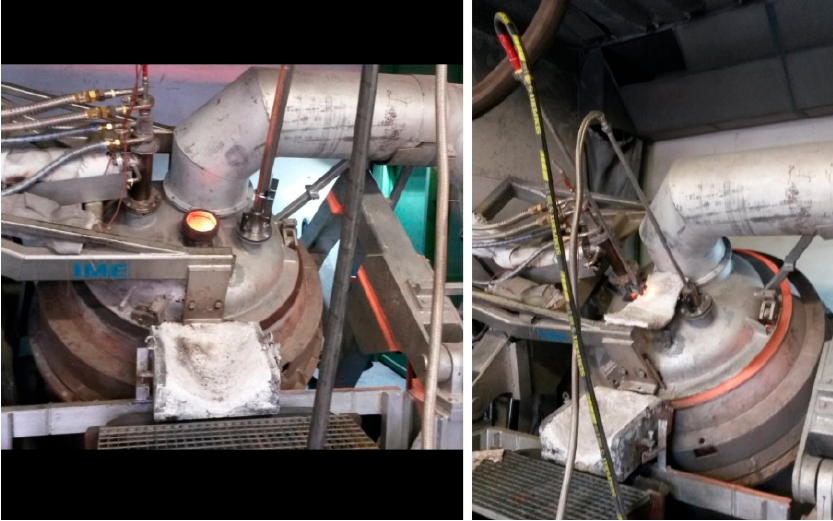
Figure 3. Top-blown rotary converter (TBRC) with lances for injecting WEEE powders and oxygen [5].